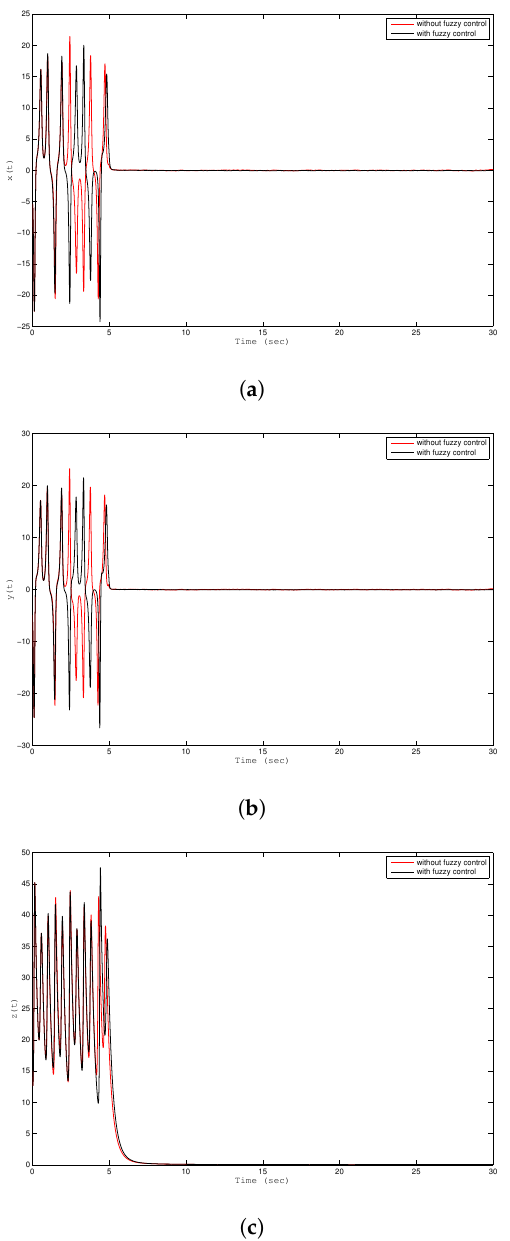
Figure 6. State trajectories of stabilized uncertain fractional-order Chen system: ( a ) x state; ( b ) y state; and ( c ) z